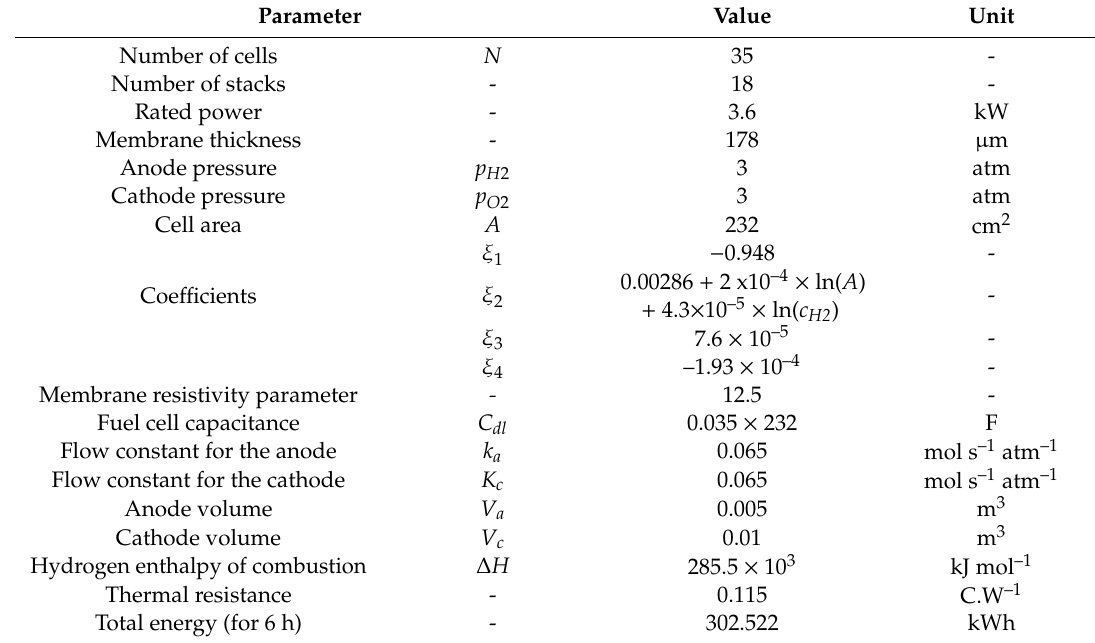
Table 6. Fuel cell system parameters [38,41].